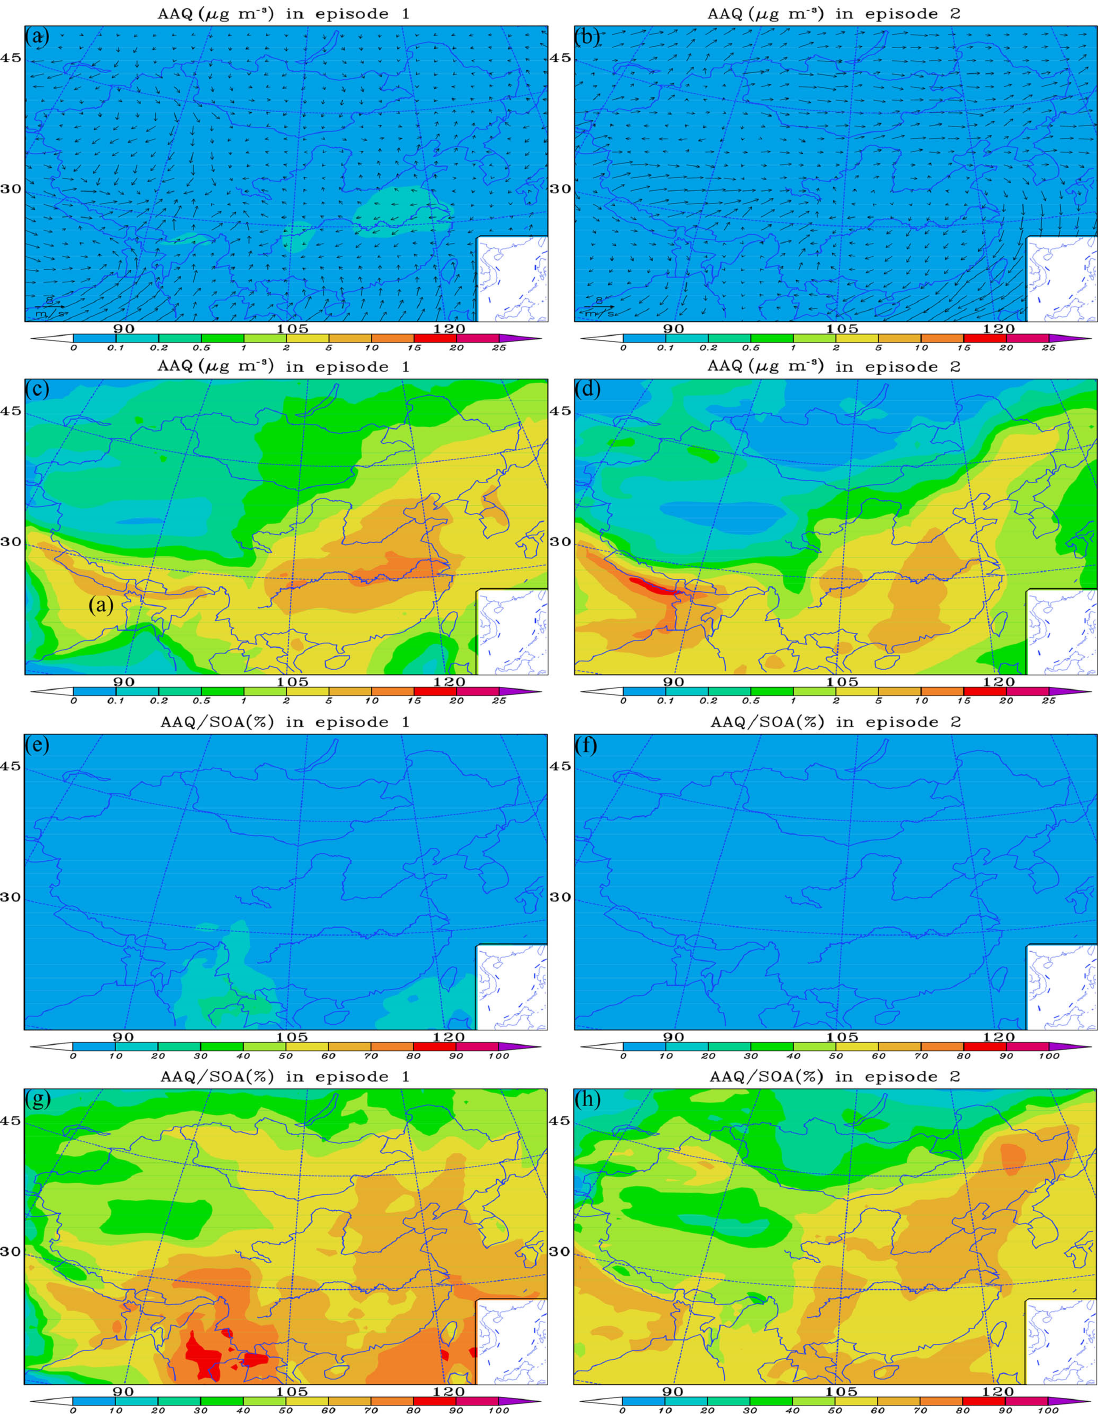
Figure 6. Modeled distributions of the mean (a, b) wind field with SOA formed from dicarbonyls (AAQ) in case 0, (c, d) AAQ in case 2, (e, f) AAQ / SOA in case 0 and (g, h) AAQ / SOA in case 2, over the regions during two episodes. Case 0 is the base run; case 2 is run taking into consideration the incorporation of the reactive uptake of dicarbonyls (excluding the default in-cloud dicarbonyl oxidations) and the underestimation of